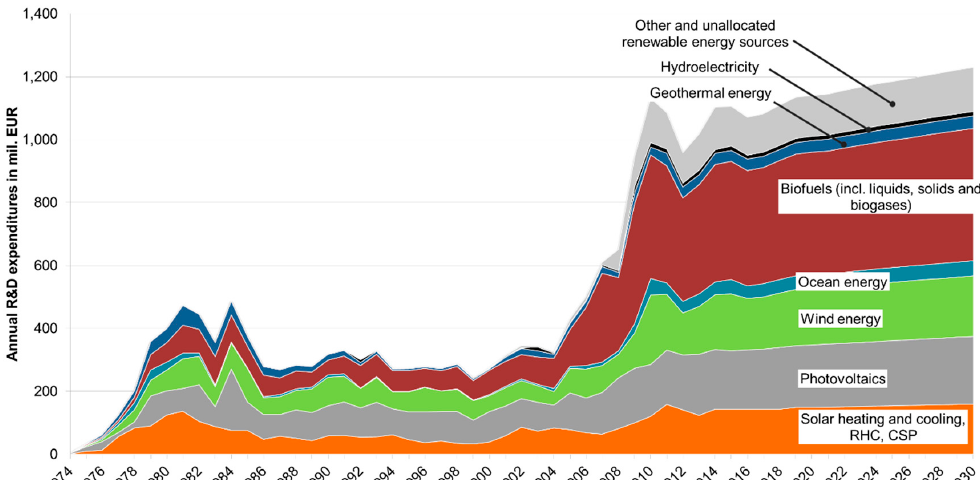
Figure 1. Renewable energy sources R&D expenditures of the EU MS from 1974 to 2015 and estimated until 2030 (Mil. EUR, BAU scenario) (2014 prices and exc. rates).